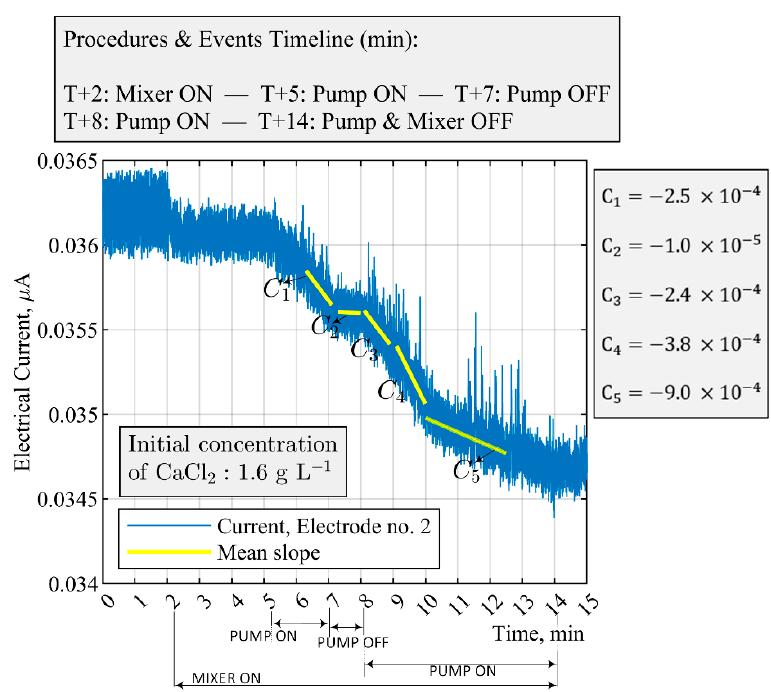
Figure 10. Fault detection and malfunction situation for case no. 2 in Table 3. The stirrer is continu- ously on (100 RPM), and a malfunction is enforced on the pump at T + 7 min. Precipitation is ongoing only when the feed pump is on. The feed flow rate is 40 mL min − 1